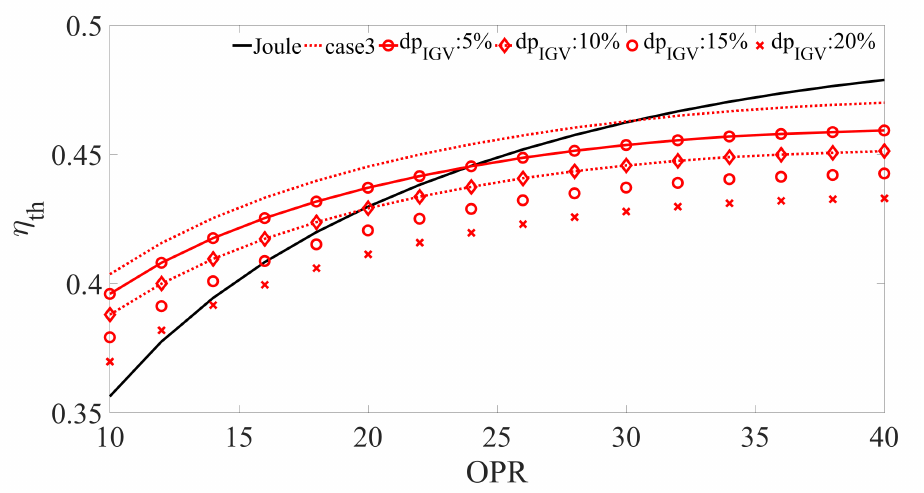
Figure 14. Cycle efficiency as a function of pressure ratio and IGV pressure drop for a TIT of 1700 ◦